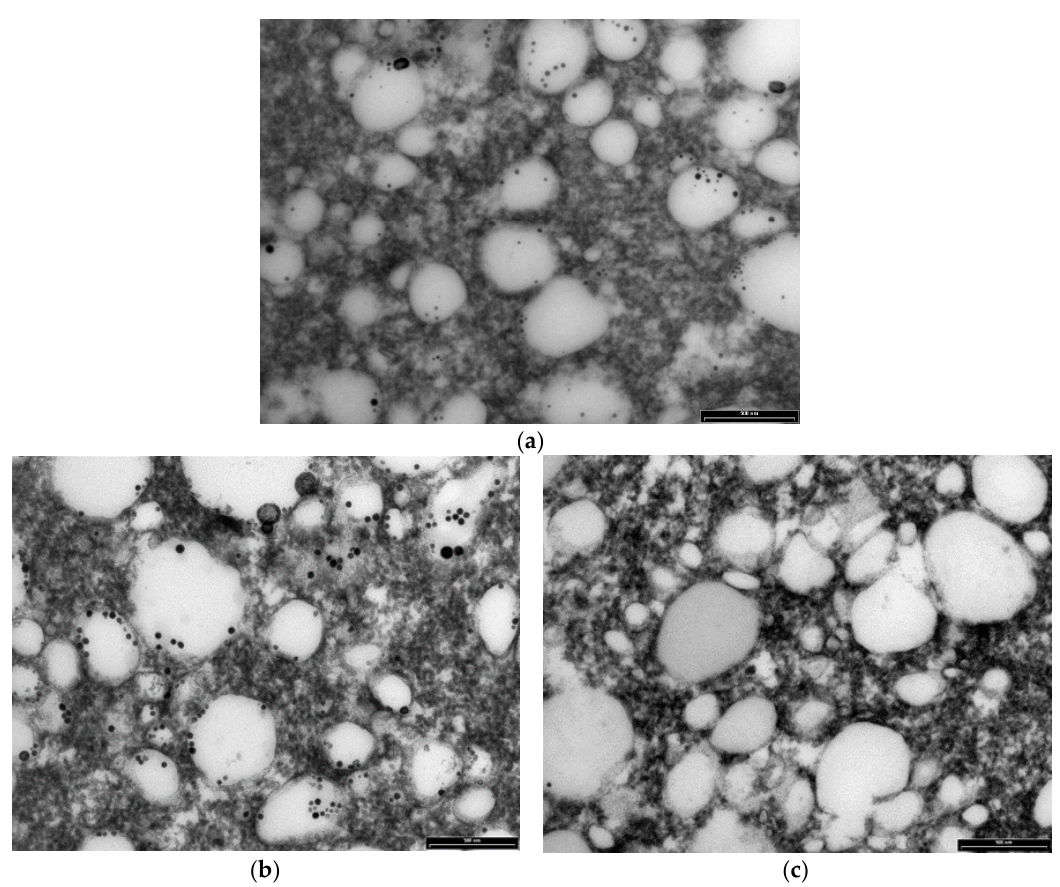
Figure 6. Transmission electron micrographs (higher magnification) of mature full-fat cheese samples ( a ) no catechin (control cheese), ( b ) 250 ppm free (+)-catechin and ( c ) 500 ppm free (+)-catechin. The white areas represent fat globules, and the dark areas are protein (casein) matrix surrounding the fat globules. Scale bar: 500 nm.